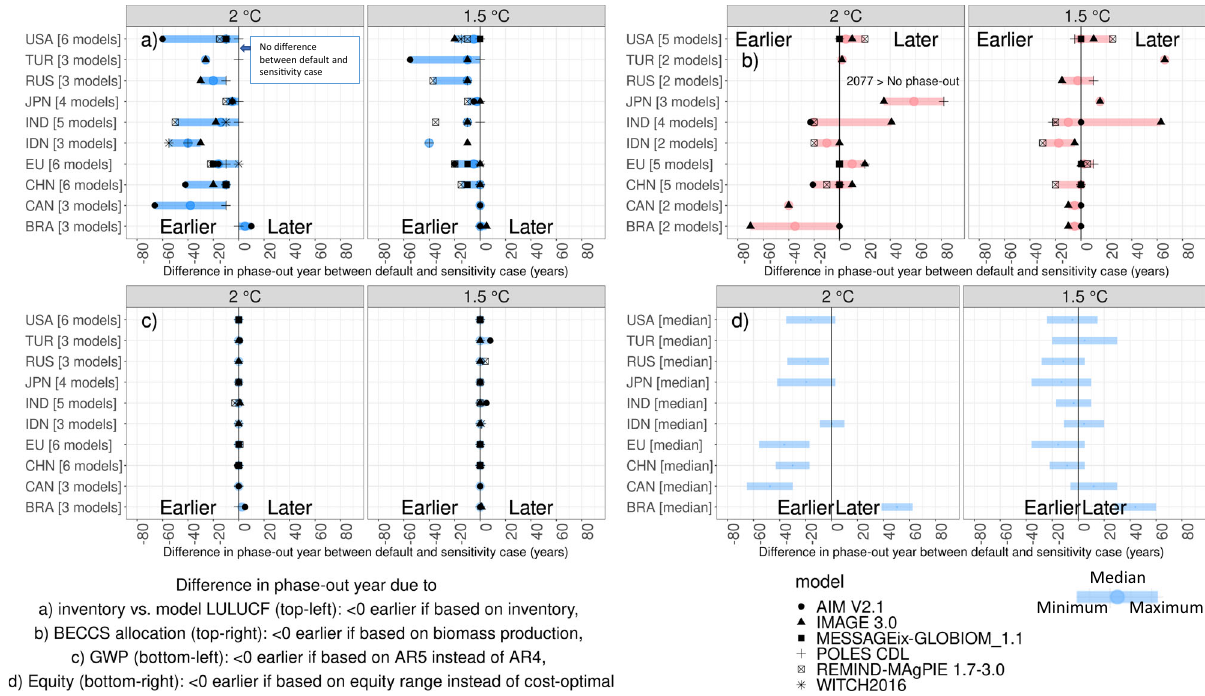
Fig. 2 In fl uence of de fi nitions on projected phase-out years. Change in projected phase-out years for a all GHG emissions including land use when harmonizing the model projections towards the countries ’ land-use emissions estimates, i.e., by adding the absolute emissions difference in 2010 between the inventory data and the model data to the model projections; values smaller than 0 indicate an earlier phase-out when emissions projections of individual models are harmonized to the inventory LULUCF data. b CO 2 emissions when negative emissions from BECCS are allocated to the biomass producer instead of the carbon-storing country (note that results are shown for fewer models, as POLES did not report the required variable agricultural production of energy crops). c The sum of CO 2 , CH 4 , N 2 O and SF 6 emissions when using 100-year global warming potentials from the Fifth Assessment Report (AR5) of IPCC instead of the fourth (AR4). d All GHG emissions when the equity ranges from Robiou du Pont et al. 25 are used instead of the model median for the default cost-optimal approach, noting that the results reported by Robiou du Pont et al. 25 do not go beyond 2100, whereas the cost-optimal scenarios do. Therefore, India and Turkey are not shown for the 2 °C scenario, because the equity range included 2100 (which may actually mean somewhere after 2100), while the cost-optimal median phase-out year was calculated as being beyond 2100 in these two cases. Individual models are indicated by symbols, whereas the error bars show the minimum – maximum range from models (enlarged circle: median). Extrapolated emissions data were used to calculate the phase-out year difference, so as to not introduce a bias when calculating differences in phase-out years. Vertical lines at 0 indicate no difference between the default and sensitivity cases. BRA: Brazil, CAN: Canada, CHN: China, EU: European Union (EU27 + UK), IND: India,